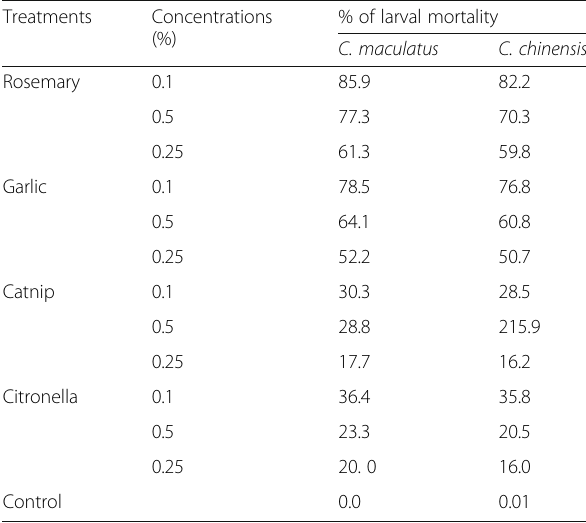
Table 4 The insecticidal efficacy of nano-oils tested on larval mortality% of the target pests Treatments